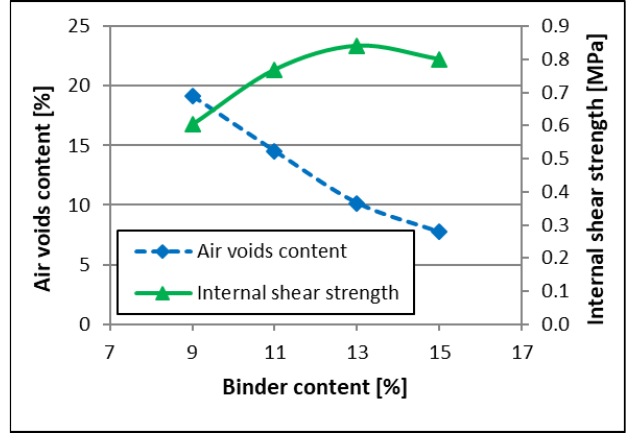
Figure 4. SEPOR-PSMA5 W4 laboratory test results.